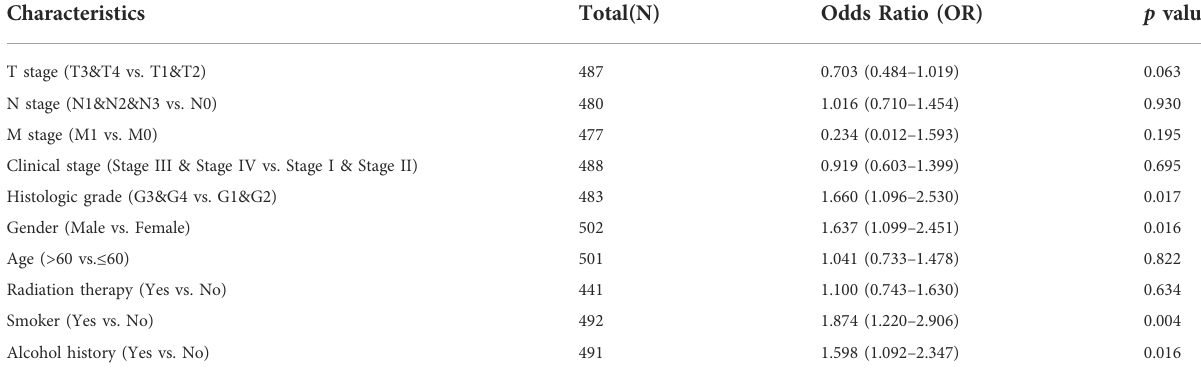
TABLE 1 The association between INMT expression and clinical-pathological characteristics (logistic regression).